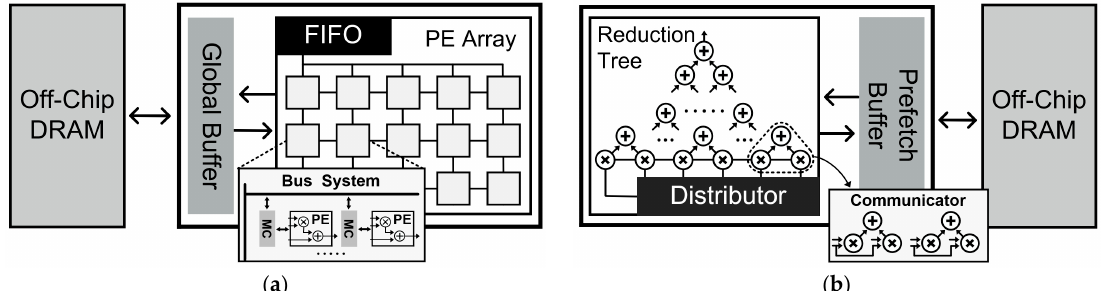
Figure 2. Two types of hardware accelerators: ( a ) processing elements (PE) array structure and ( b ) reduction tree structure.